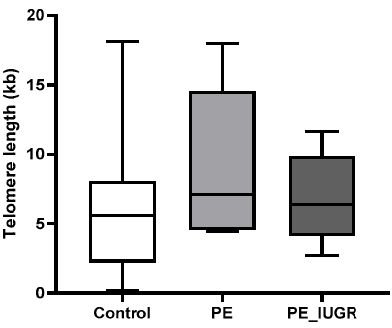
Figure 2. Absolute telomere length in pre-eclampsia. aTL in placental tissue was not significantly altered in pre-eclampsia or pre-eclampsia associated with IUGR compared with controls. Data are represented as mean aTL ± SD, p < 0.05. Table 2. Crude and adjusted association between placental absolute telomere length (aTL) in kbp for pre-eclampsia and pre-eclampsia associated with IUGR, compared with controls. a Adjusted for maternal age, BMI, gestational age, ICC, and foetal sex. Abbreviations: 95% CI = 95% confidence interval, BMI = body mass index, ICC = individualised customised centile, aTL = absolute telomere length. Exposure Groups